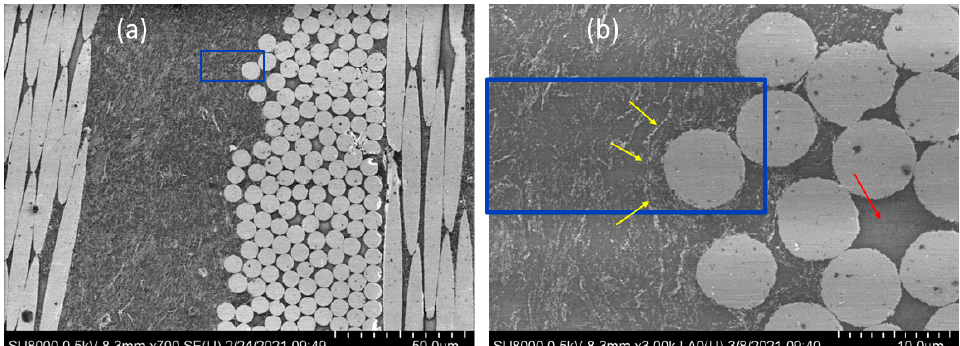
Figure 8. SEM images of the PEEK-GSPEEK/CF laminate showing the area selected for nanoindenta- tion mapping (blue rectangle) at ( a ) lower and ( b ) higher magnifications. Yellow arrows indicate the accumulation of graphene at the fibre front. The red arrow denotes a region inside the tows without graphene.